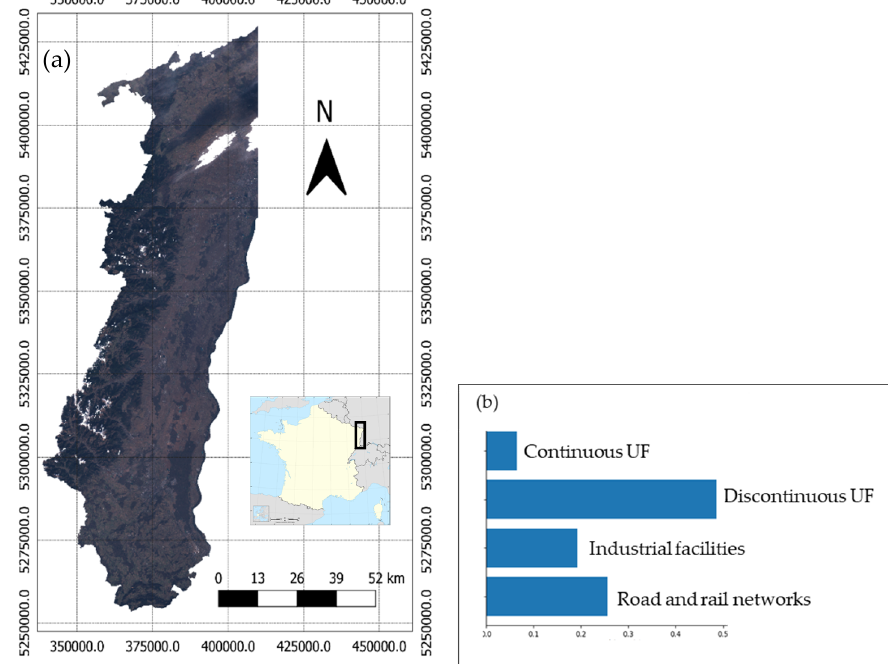
Figure 2. ( a): Study area: (a) the Alsace region of France; ( b ) the percentage of each class in the dataset. The regional land use/cover vector database (BDOccsol©GeoGrandEst) produced by visual interpretation of aerial photography is used as reference data [33]. The most up-to-date version (2012) available through the regional data infrastructure GeoGrandEst, maps the study area into 55 thematic classes. The legend is organized into four levels of nomenclature. The first level categorizes land cover into four classes: (1) artificial surfaces, (2) agricultural areas, (3) forest areas, and (4) water surfaces. Artificial surfaces (Level 1) are further sub-divided into 12 classes at Level 3. Table 1 details the four generic urban thematic classes obtained after